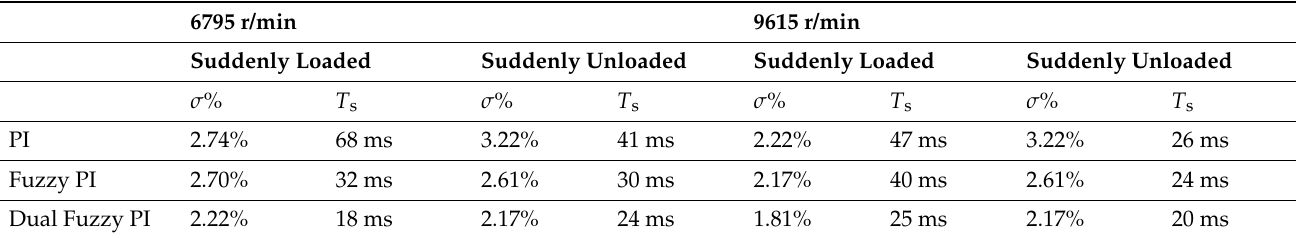
Table 5. Simulation result data